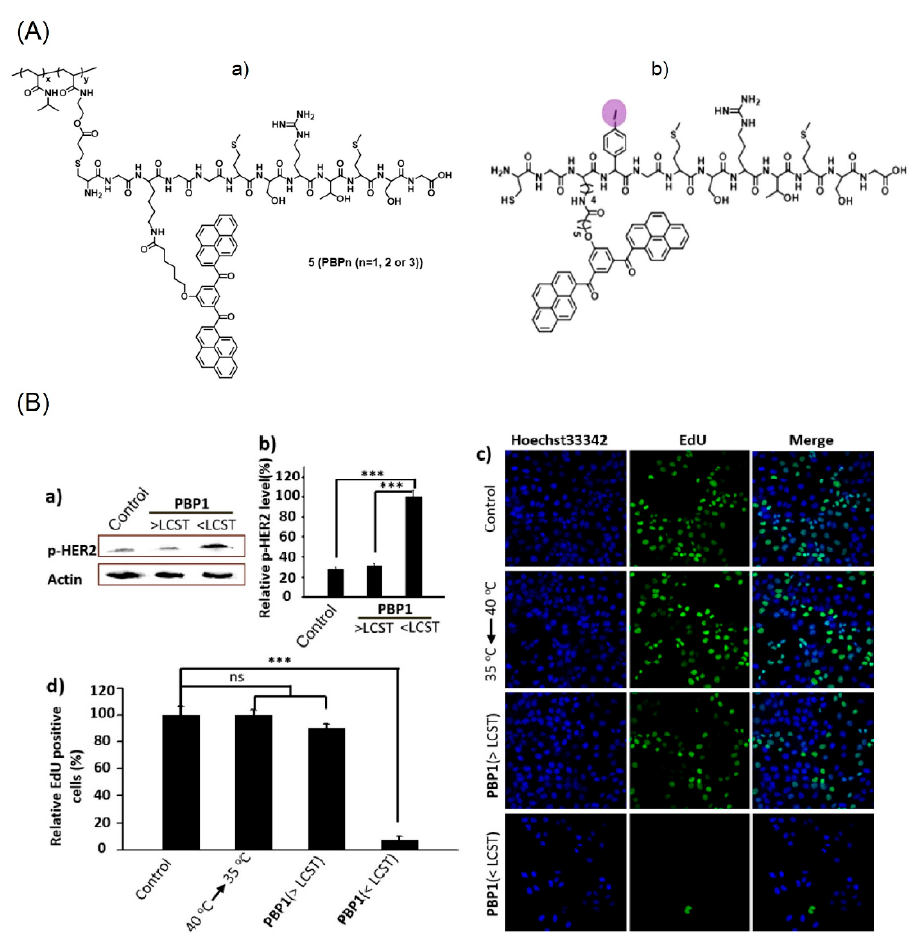
Figure 5. ( A ) ( a , b ) structures of HPB containing polymers. ( B ) ( a ) Western blot analysis of HER2 phosphorylation induced by HBP aggregation at 40 °C (>LCST) and 35 °C (<LCST). ( b ) Bar chart represents the normalized band intensity ratio of p-HER2 as quantified by ImageJ. Actin was used as a loading control. ( c ) Detection of EdU incorporated into the DNA of cultured SK-BR-3 cells after different treatment by fluorescence microscopy. ( d ) Histogram shows significant decrease of EdU-labeled cells in the PBP1 treated SK-BR-3 cells at 35 °C (<LCST), and temperature change alone had no effect on cells. EdU-labeled cell number of different treated groups were compared. *** p < 0.001; ns, not significant; one-way ANOVA for indicated comparison. The results are the mean values ± SD of independent experiments performed in triplicate (Reproduced with the permission from Ref. [72]).